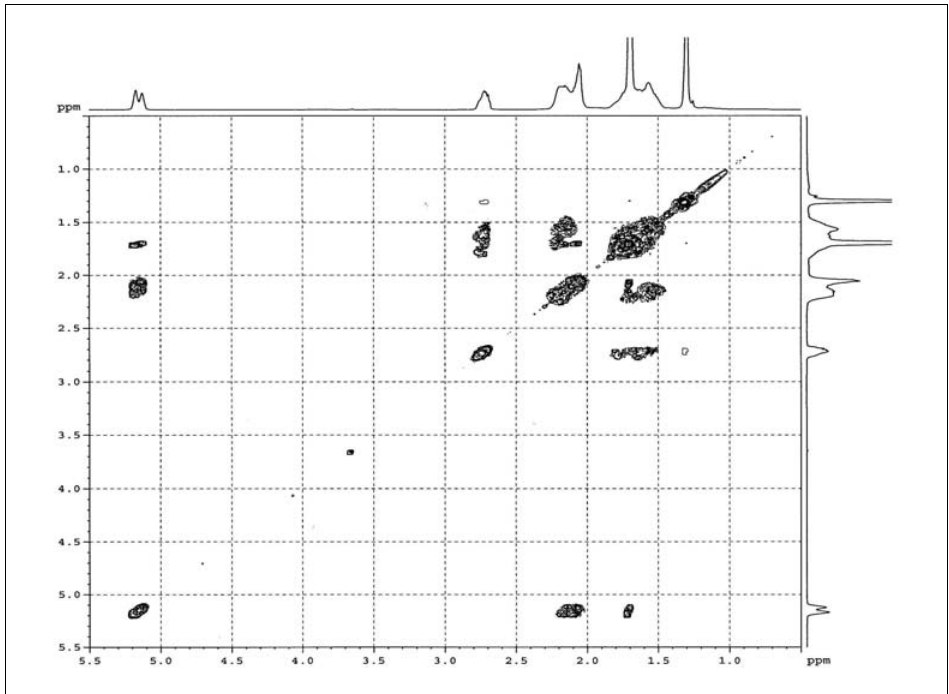
Figure 6. COSY spectra of purified